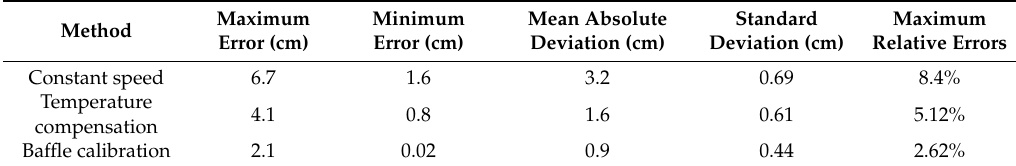
Table 4. Statistical analysis of measurement errors for the three